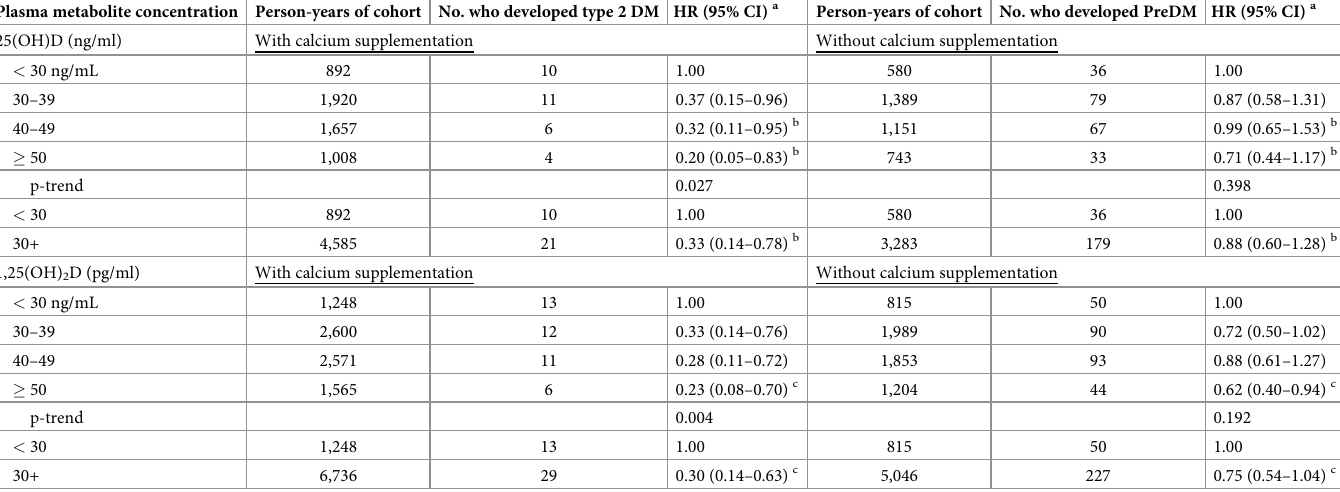
Table 4. Hazard ratios with 95% confidence intervals of type 2 diabetes incidence by categories of plasma vitamin D metabolite concentrations by use of calcium supplements, Rancho Bernardo cohort,